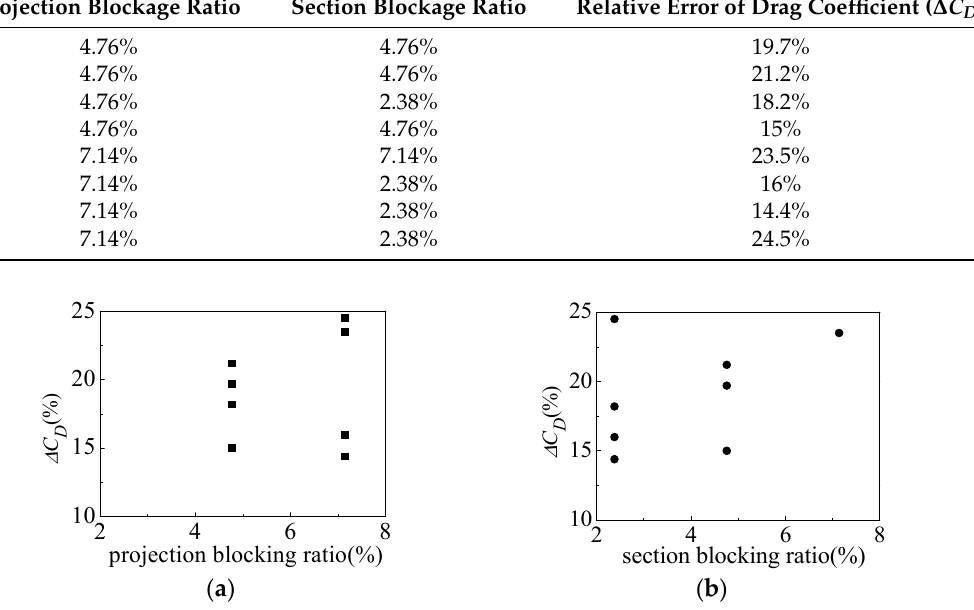
Figure 19. Δ C D varying with blockage ratio. ( a ) Δ C D varying with projection blockage ratio; ( b ) Δ C D Figure 19. ∆ C D varying with blockage ratio. ( a ) ∆ C D varying with projection blockage ratio; ( b ) ∆ C D varying with section blockage ratio. varying with section blockage